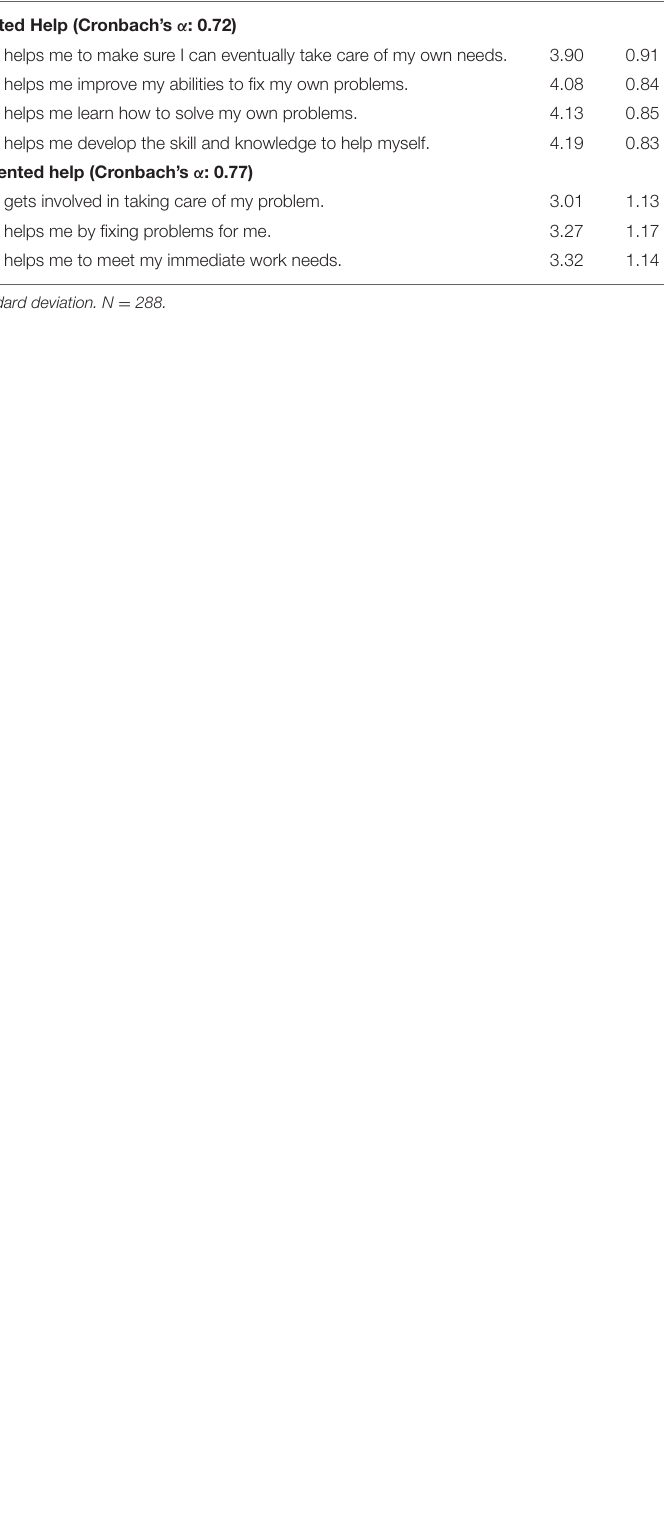
TABLE A1 | Analysis of autonomy-/dependency-oriented help scale items.